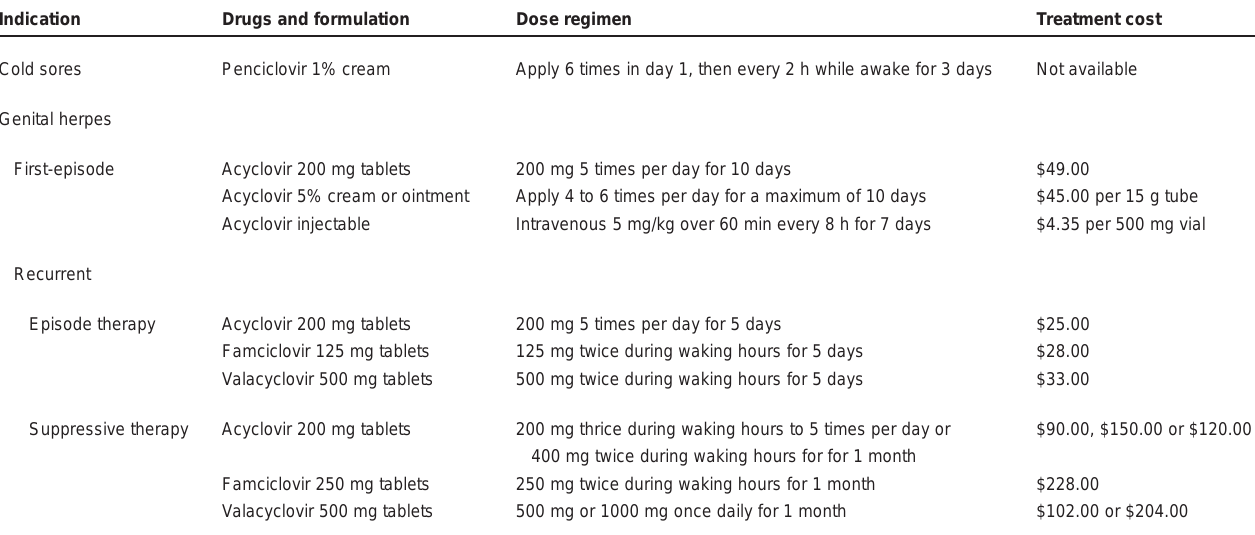
TABLE 2 Therapeutic Products Directorate (TPD) of Health Canada approved indications for the treatment of mucocutaneous herpes simplex virus infections in the normal host Indication Drugs and formulation Dose regimen